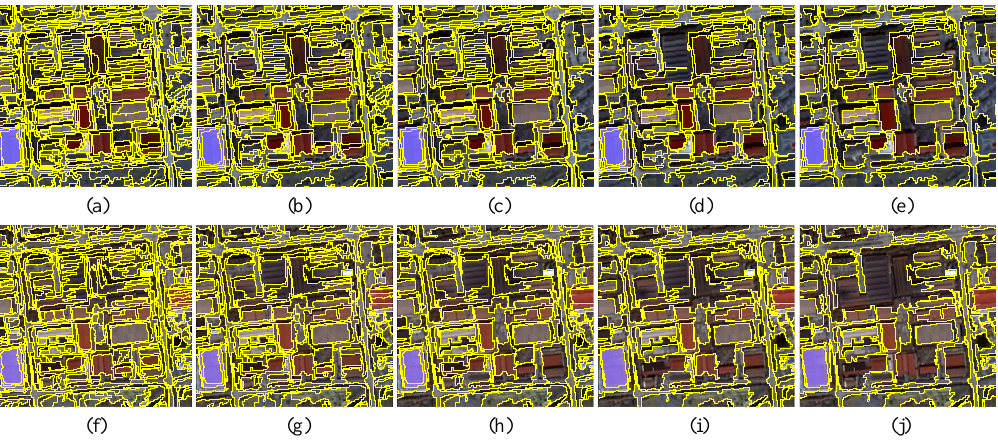
Figure 7. Subsets of segmentation maps with different scales in Experimental Area B. ( a – e ) are the scales from 40–120 in steps of 20 for the image acquired in 2015; ( f – j ) are the scales from 40–120 in steps of 20 for the image acquired in